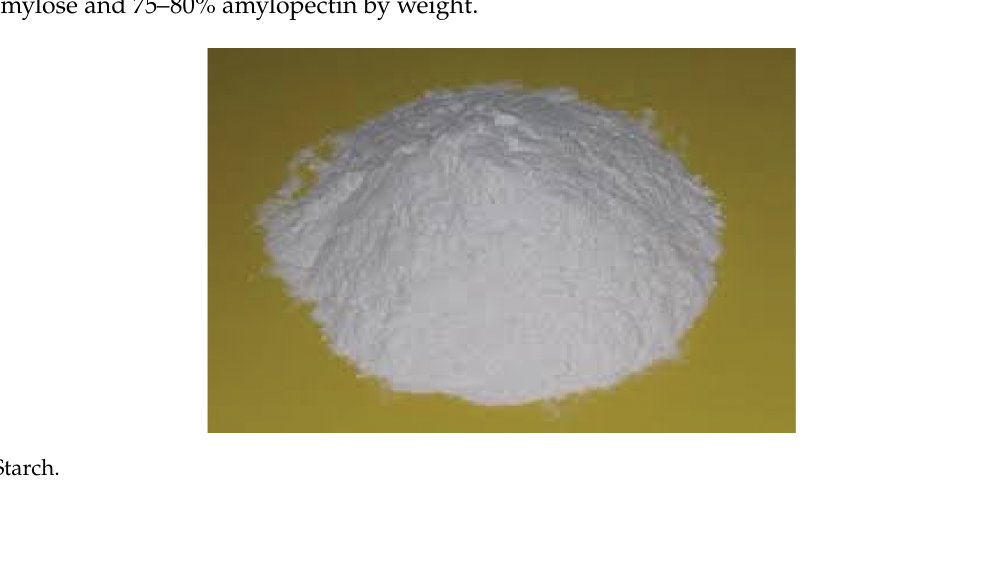
Table 1: Properties of starch [23], https://en.wikipedia.org/wiki/Starch]. Molecular